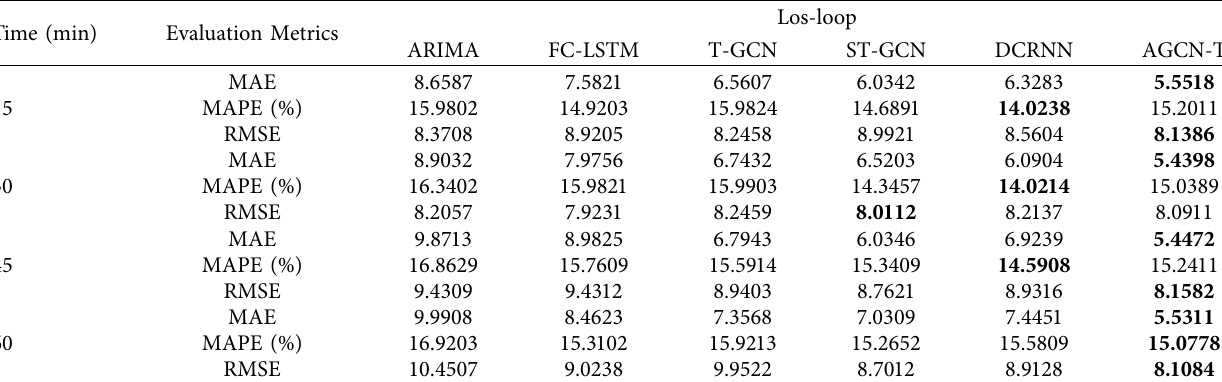
Table 5: Prediction performance of each method on